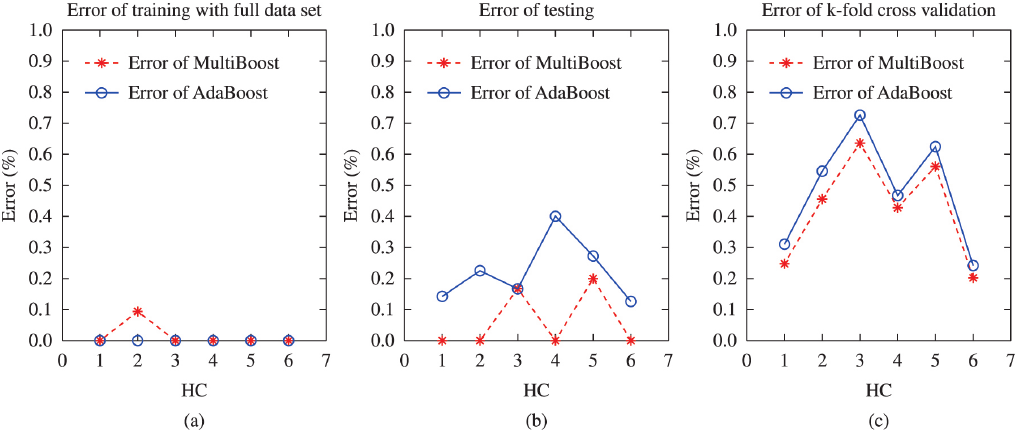
Figure 9. Errors (%) of AdaBoost and MultiBoost algorithm. a) Errors with training subset, b) Errors with testing subset, c) Errors with k -fold cross validation